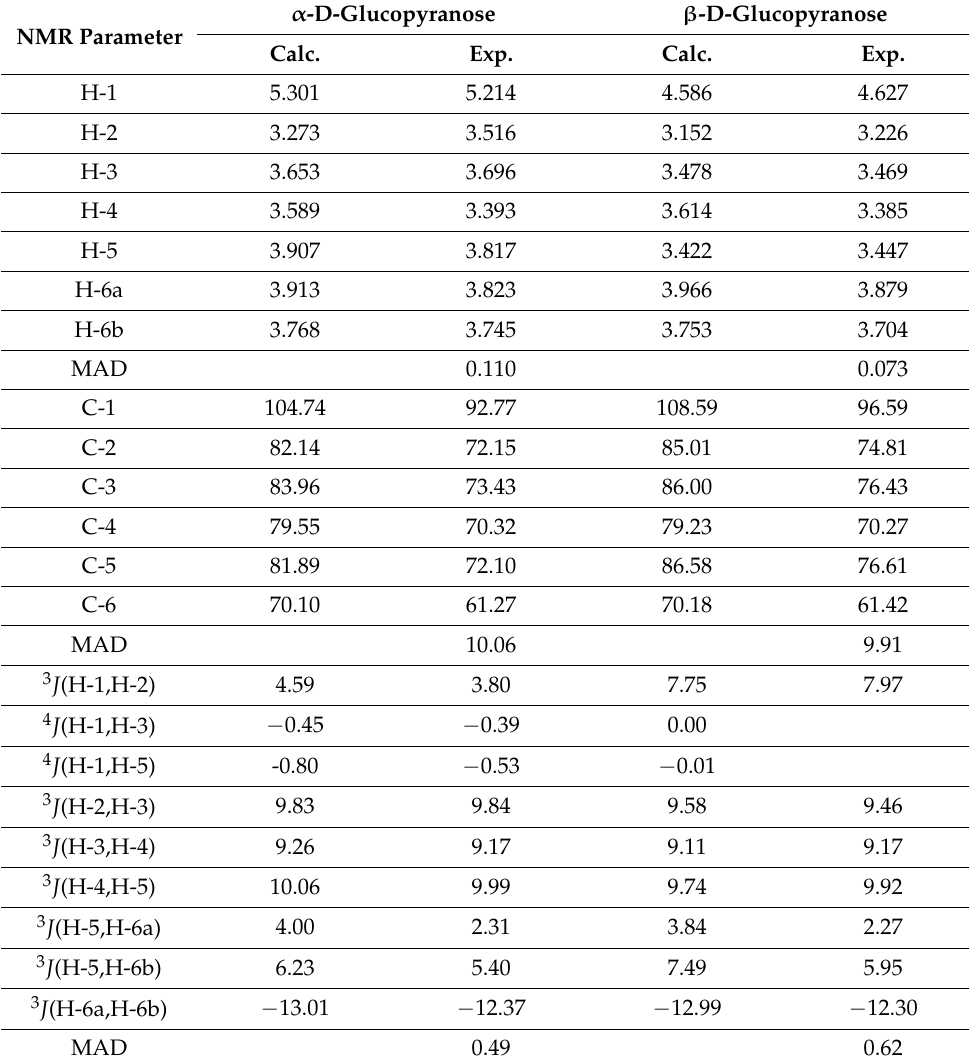
Table 1. Comparison of calculated and experimental values of δ H (ppm), δ C (ppm), and J H,H (Hz) of the α and β anomers of D-glucopyranose. Compiled from Roslund et al. [111]. α -D-Glucopyranose β -D-Glucopyranose NMR Parameter Calc. Exp. Calc. Exp.